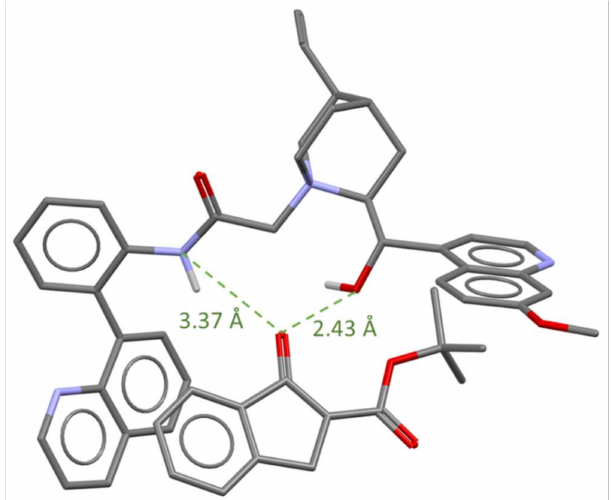
Figure 2. Model of a possible intermediate state for the